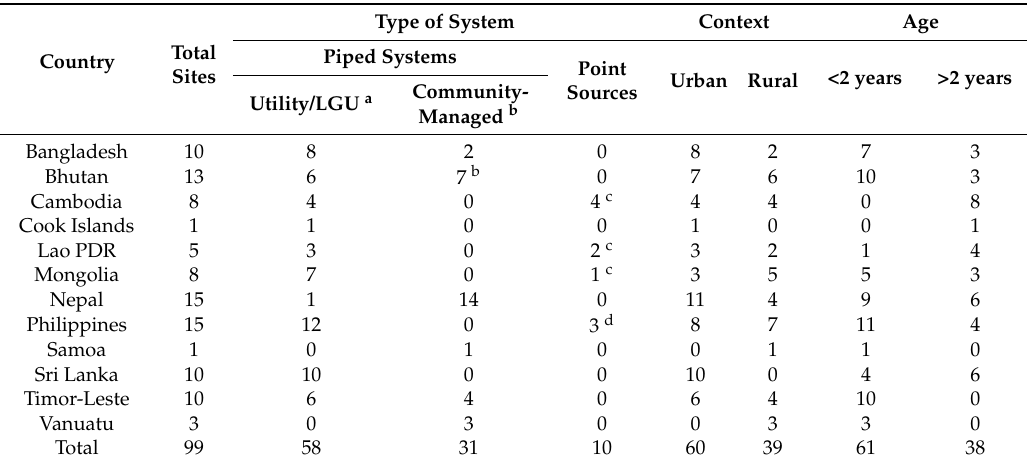
Table 1. Number of sites that participated in the WSP impact assessment by country, type of water system, context (urban/rural), and WSP